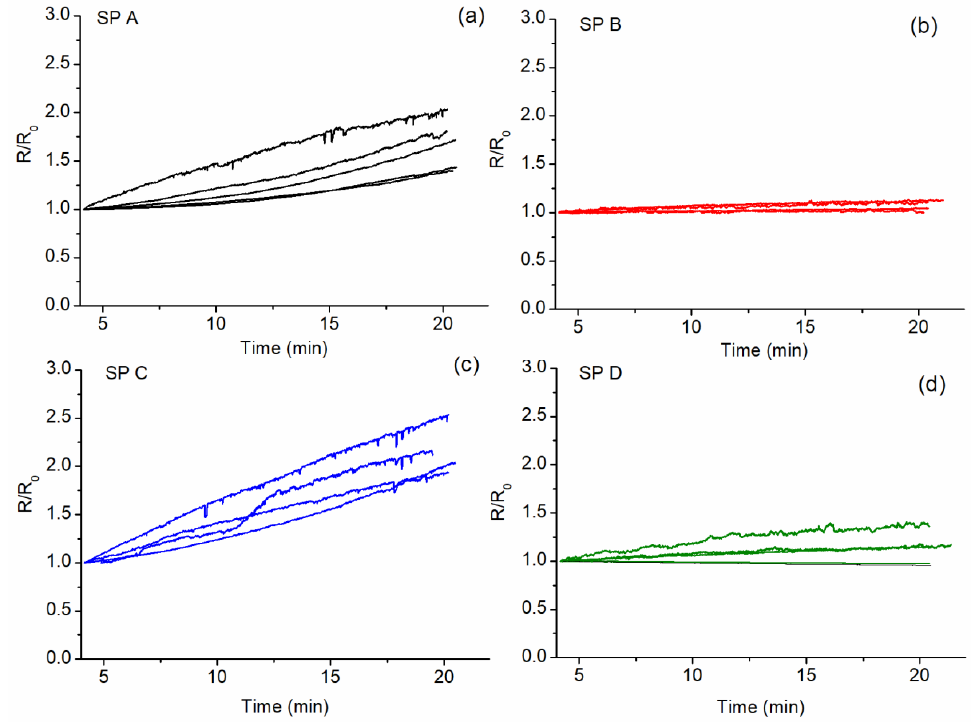
Figure 9. Electrical resistance evolution over time between 4 and 20 min of constant voltage application, presented as a fraction of the initial resistance (R/R 0 ) for 0.40% CNT–cement composites. ( a ) SP A, ( b ) SP B, ( c ) SP C and ( d ) SP D.